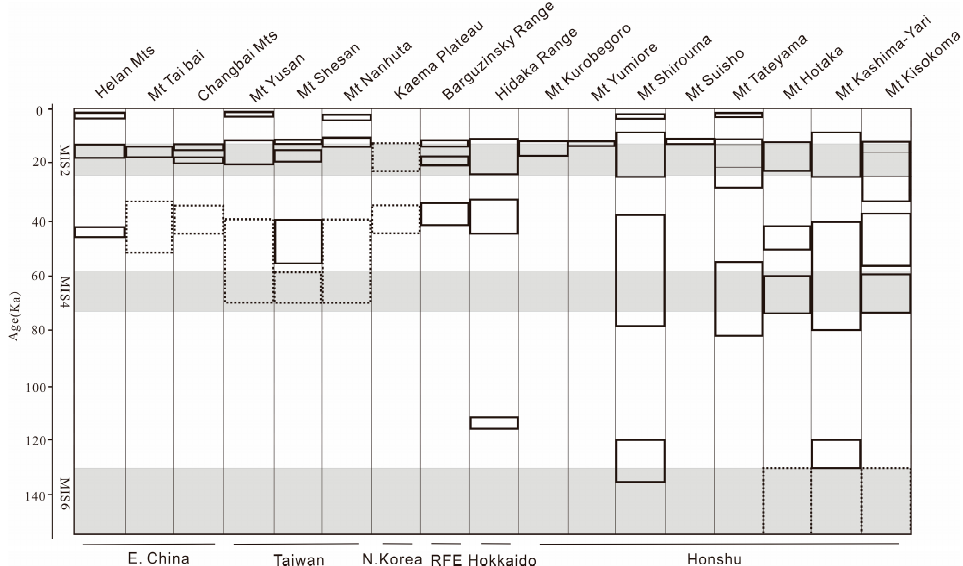
Figure 2. Comparison of the Late Quaternary glacial stages of different mountains in the EAM region. The solid lines represent the exact glacial stage, and the dotted lines represent the inferred glacial stage; The shaded areas represent the global cold period, and the unshaded areas represent the global warm period.